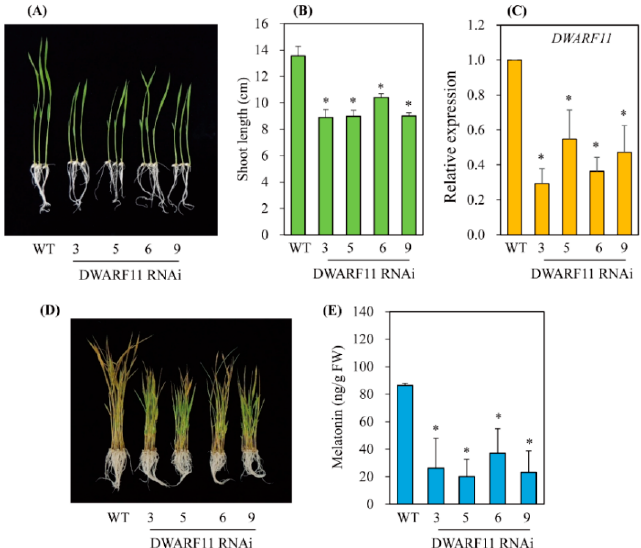
Figure 4. Generation of DWARF4- suppressed transgenic rice plants. ( A ) Phenotypes of 7-day-old wild-type (WT) and DWARF4 RNAi transgenic (T 2 ) rice seedlings. ( B ) Shoot length measurement. ( C ) qRT-PCR analyses of WT and transgenic (T 2 ) lines. ( D ) Phenotypes of 7-day-old rice seedling after cadmium treatment. ( E ) Melatonin levels of WT and transgenic lines. Seven-day-old rice seed- lings were challenged with 0.5 mM cadmium for 3 days for quantification of melatonin. Asterisks (*) indicate significant differences from the wild type ( p < 0.05), as determined by Tukey’s HSD post- hoc tests.